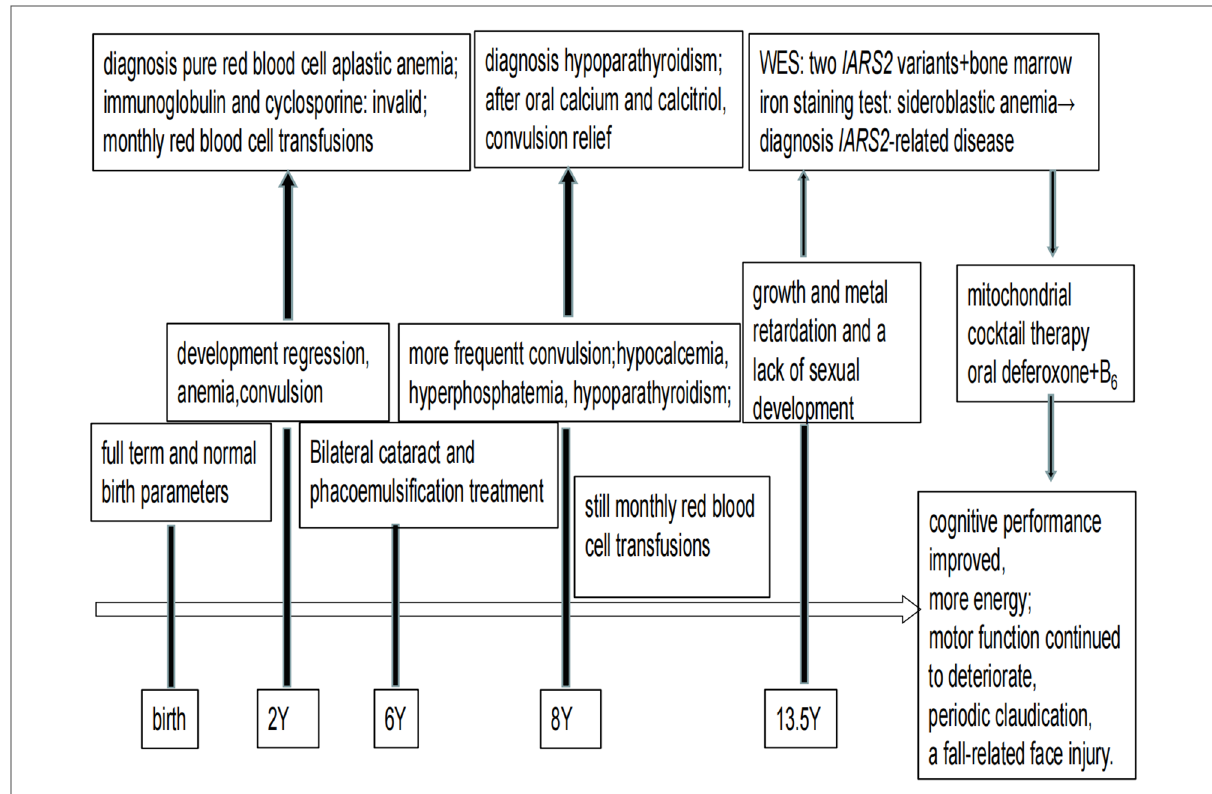
FIGURE 3 Timeline of disease